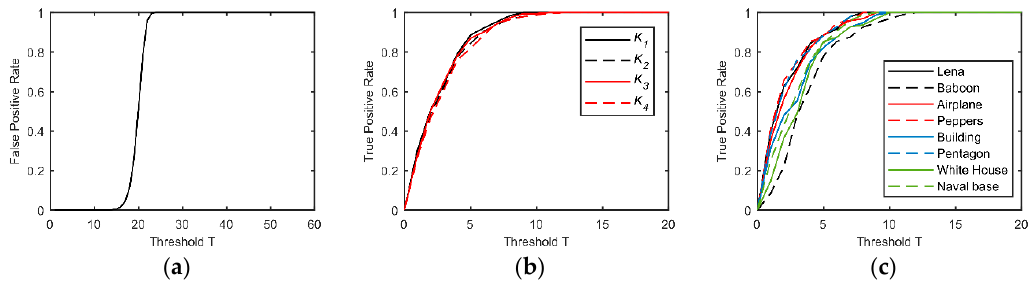
Figure 13. Influence of different thresholds on ( a ) false-positive rate of one LSFR and on true-positive rate between different ( b ) keys and ( c ) images.